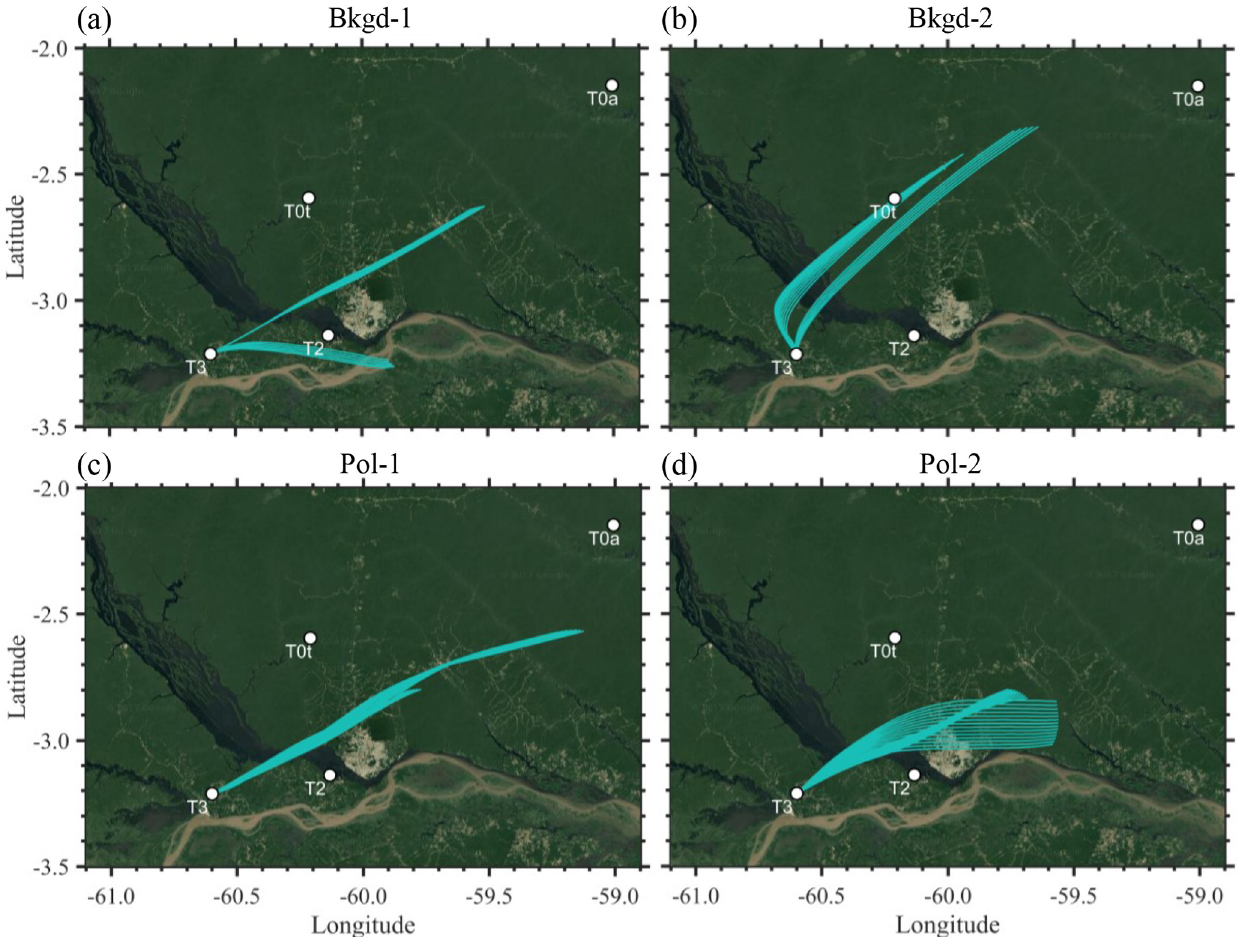
Figure 7. Air mass back trajectories associated with the four clusters of the FCM analysis for the case studies in Fig. 6. Trajectories were calculated using HYSPLIT 4 in steps of 12min for 10h (Draxler and Hess, 1998). Image data: Google